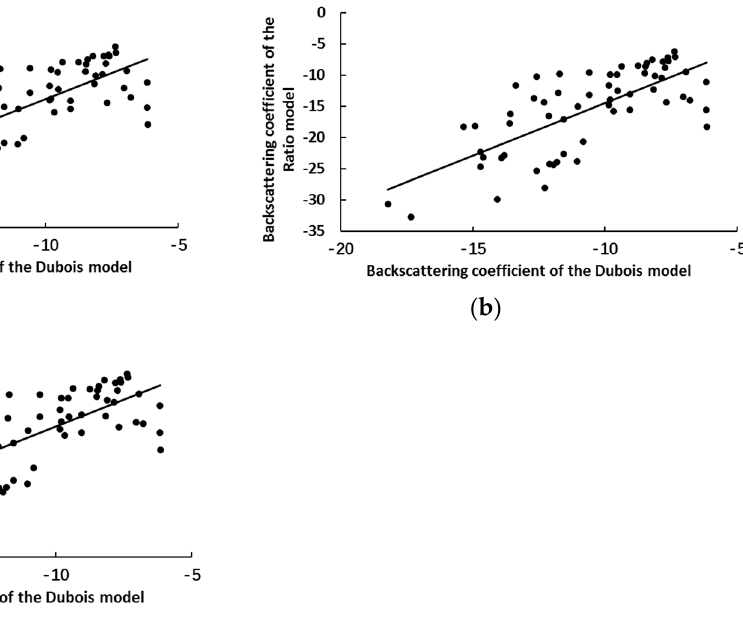
Figure 8. Scatter plot of backscattering coefficient of HH polarization of Dubois model and ratio model ( a ) VWC; ( b ) NDVI; ( c ) EVI.